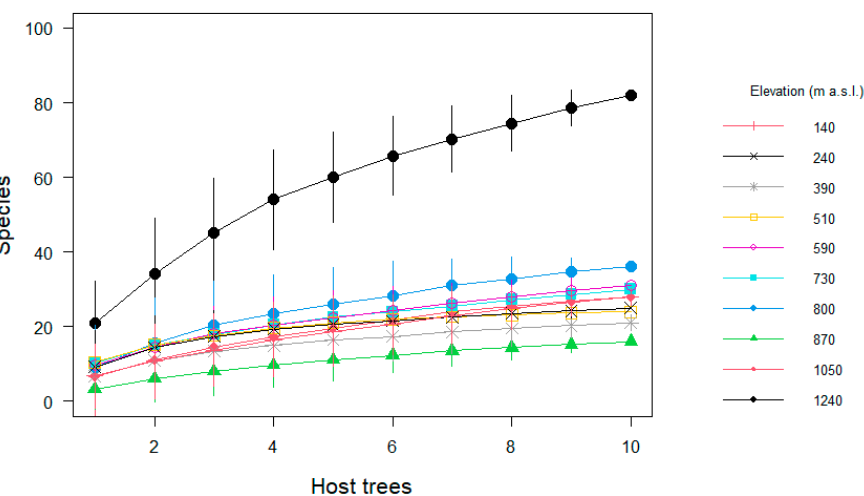
Figure 3. Species accumulation curves of epiphyte assemblages on host trees from pasture sites distributed along an elevational gradient in Gualaca district, Panama. Data show the mean ± the standard deviation of species in every pasture.